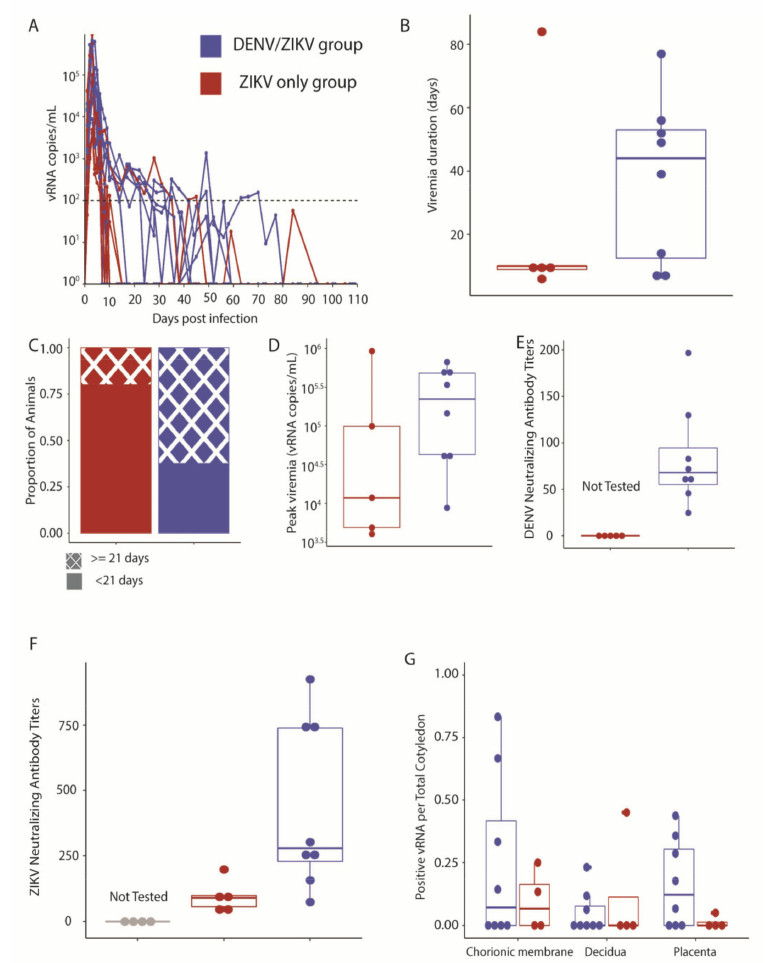
Figure 4. Maternal ZIKV infection characteristics and neutralizing antibody responses. ( A ) Plasma viremia curves for individual animals, denoted by different lines for each animal. Dashed line is the limit of quantification. ( B ) Duration of viremia, from the day of inoculation until the last day of a positive plasma viral load ( t -test, p -value = 0.4638). ( C ) Proportion of dams within each group with viremia duration greater or less than 21 days ( t -test, p -value = 0.2657). ( D ) Peak viral plasma loads, defined as the highest plasma vRNA titer ( t -test, p -value = 0.4208). ( E ) DENV PRNT90 on the day of ZIKV inoculation (ZIKV-only animals not tested). ( F ) ZIKV PRNT90 at 28 days post- ZIKV inoculation (control animals not tested). ( G ) ZIKV vRNA distribution within the maternal–fetal interface, displayed as the proportion of cotyledons with a positive viral